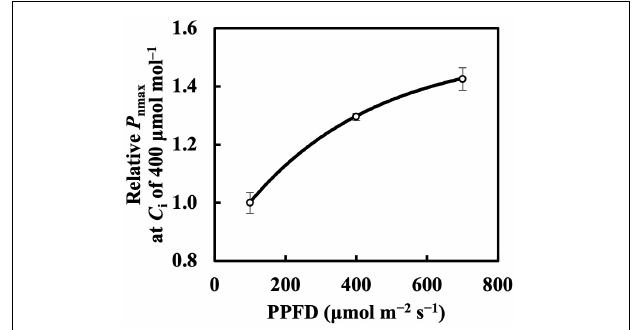
FIGURE 11 | Relative P nmax at intercellular CO 2 concentration ( C i ) of 400 µ mol mol − 1 in first true leaves of cucumber grown under constant daily PPFD levels for 6 days. All values were means ± standard errors ( n = 3) and relativized to that for 100 µ mol m − 2 s − 1 . Measured values (open circles) and estimated values (solid line) fitted with asymptotic functions are